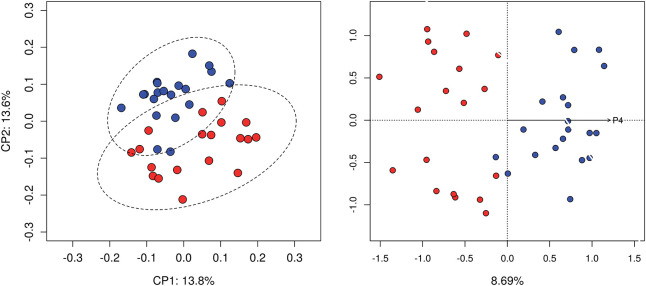
Beta diversity analysis. Principal coordinate analysis based on unweighted Unifrac distance matrix (left). dbRDA constrained ordination, 8.69% of the variance was explained by the concentration of progesterone (right). Samples at follicular (red) and luteal phases (blue) are compared.